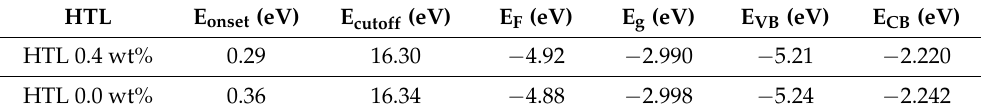
Table 1. The calculated values of energy level of the HTLs doped with and without CsI.